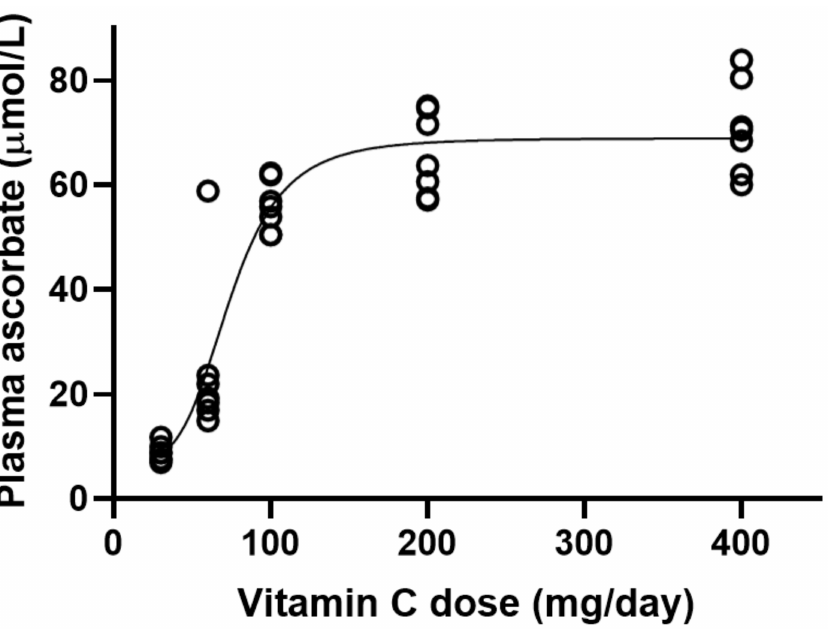
Figure 2. Steady-state plasma ascorbate concentrations in volunteers as a function of daily dose. Data were obtained from Table 1 in reference [17] and a sigmoidal curve was fitted to the data.